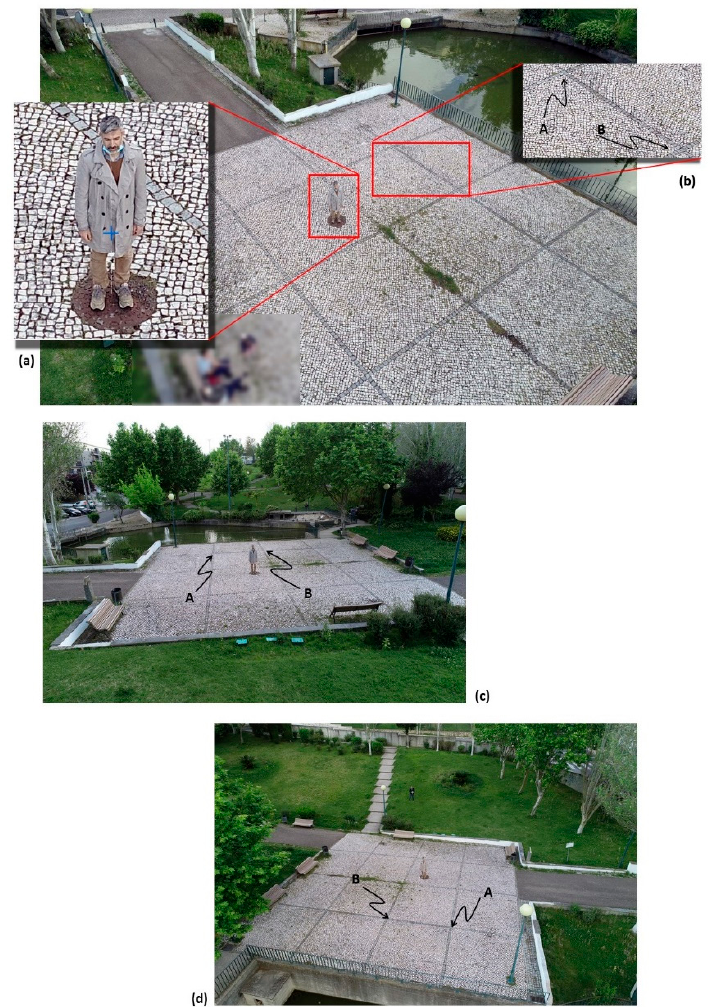
Figure 8. Still picture DJI243 acquired with Phantom 4 PRO for the estimation of human target height ( a ) using as reference distance on the ground two inner corner points visible in the floor pattern ( b ). Image DJI250 ( c ) and image DJI255 ( d ) with the indication of points A and B. Table 5. Parameters related to the still image in Figure 8 and results of the analysis for the calculation of V and target height.